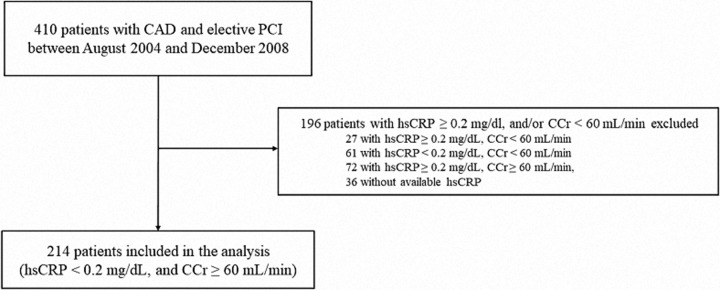
Study flow chart showing the disposition and outcome of 214 patients.Those with CCr < 60 mL/min and hsCRP ≥ 0.2 mg/dL were excluded. During a median 5.1-year follow-up, 20 patients experienced MACCE. CAD, coronary artery disease; PCI, percutaneous coronary intervention; hsCRP, high-sensitivity C-reactive protein; CCr, creatinine clearance; MACCE, major adverse cardiac or cerebrovascular events; ACS, acute coronary syndrome; CHF, congestive heart failure.